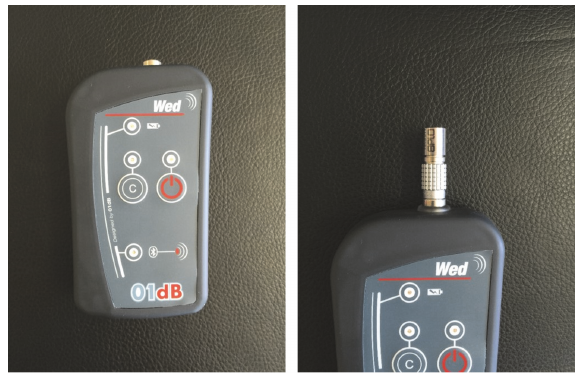
Figure 4: Preliminary sample survey flow chart to detect the perceived noise